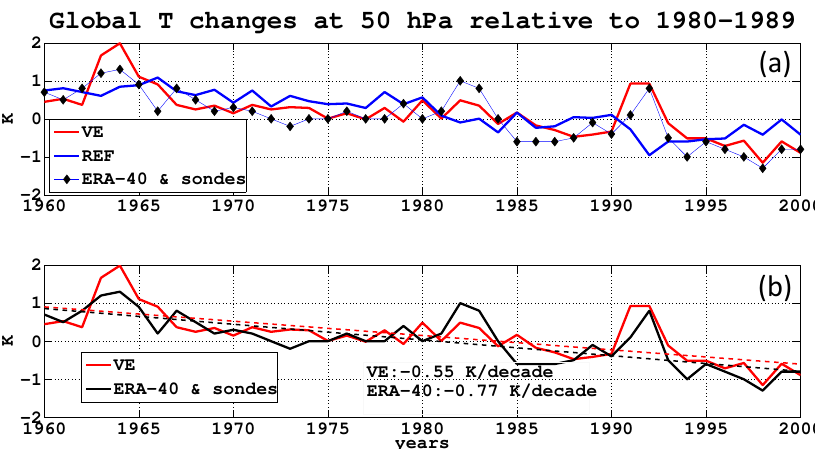
Figure 3. Time series of 50 hPa annually averaged global mean temperature anomalies relative to the 1980–1989 decadal average (VE, REF, OBS) ( a ). Linear trends of the temperature anomalies are superimposed to (VE, OBS) time series in panel ( b ) ( ´ 0.55 K/decade for VE and ´ 0.77 K/decade for ERA-40 reanalysis, for 1980–2000 trends). Observations are from Uppala et al. [58]; Free et al. [59].